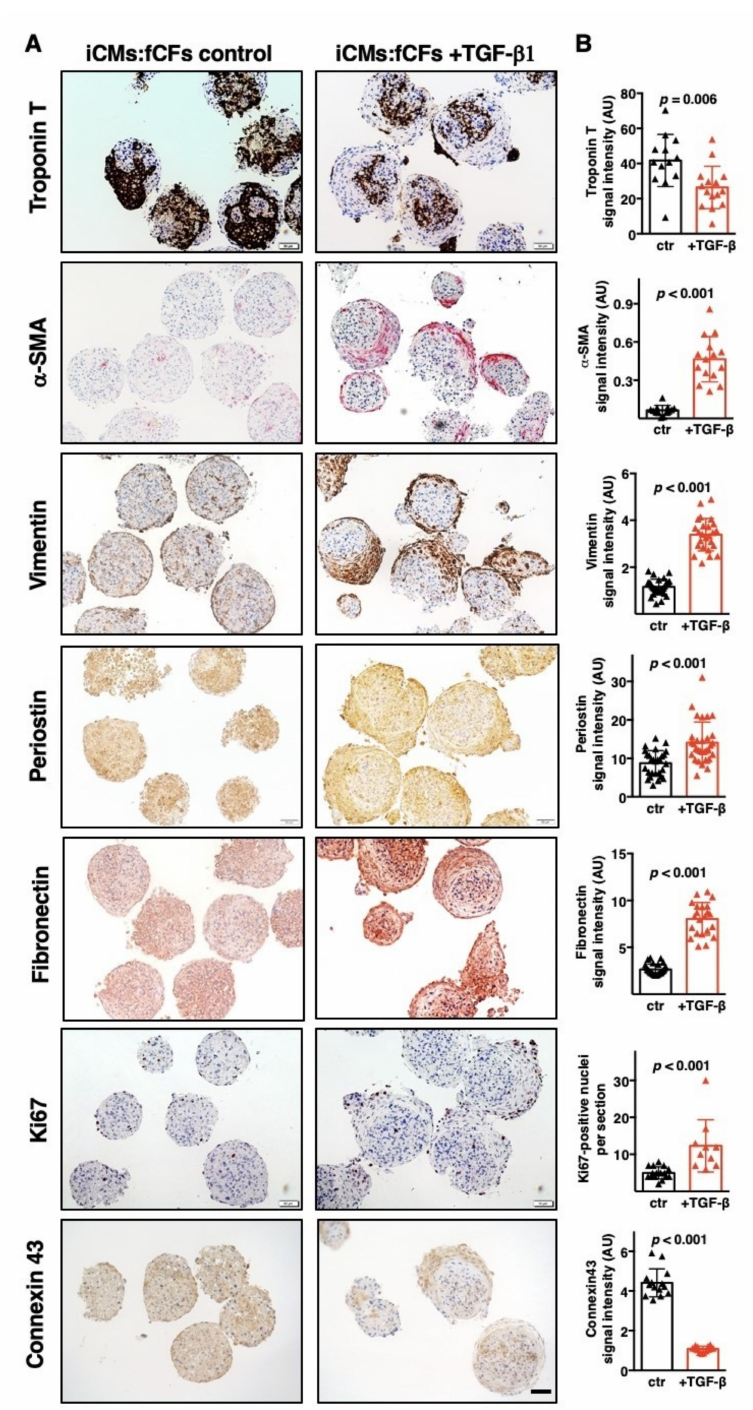
Figure 3. TGF- β 1 induces fibrotic phenotype in cardiac microtissues. Immunohistochemistry of iCMs:fCFs microtissues cultured in the presence or absence of TGF- β 1 (10 ng / mL) at day 10. Panel ( A ) illustrates representative staining for the indicated proteins at the indicated condition (bar = 50 µ m). Higher magnification pictures are available in the Supplementary Materials (Figure S3). Panel ( B ) shows quantification of the respective staining for microtissues cultured in the presence (red) or absence (black) of TGF- β 1. Graphs show cumulative data of 3 independent experiments. Each triangle represents data for one microtissue. p values were calculated with the Student’s t